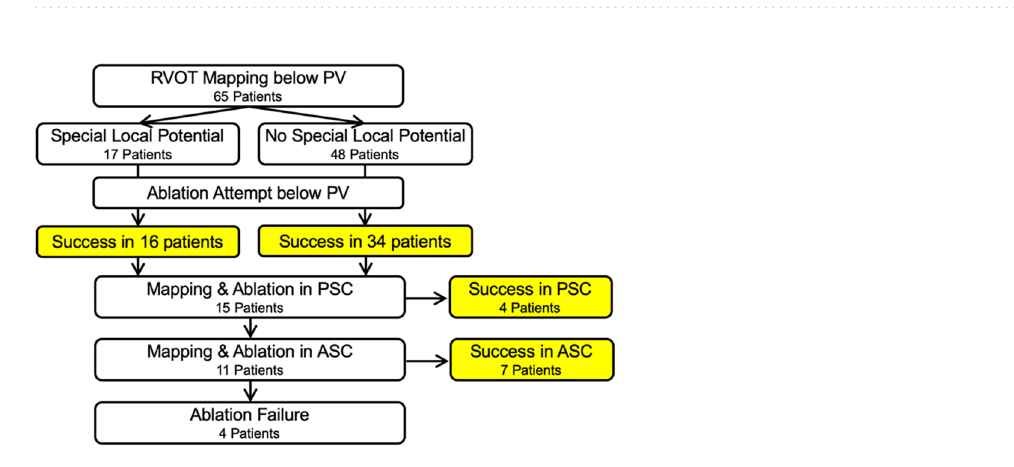
Table 1. Patient characteristics. LVEDd left ventricular end-diastolic diameter, LVEF left ventricular ejection fraction, VA ventricular arrhymia, AAD antiarrhythmic drug.